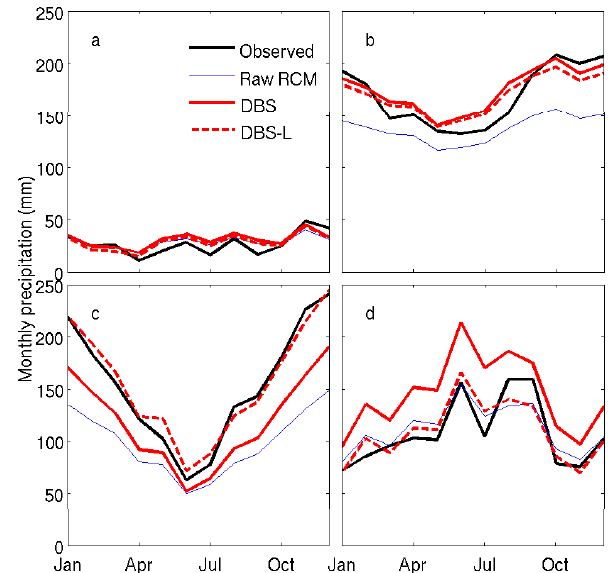
Fig. 3. Monthly precipitation for four classified weather pat- terns; (a) anticyclonic, (b) cyclonic, (c) westerly winds and (d) easterly/south-easterly winds. The figure shows the raw RCM precipitation and MOS using DBS and DBS classified on weather